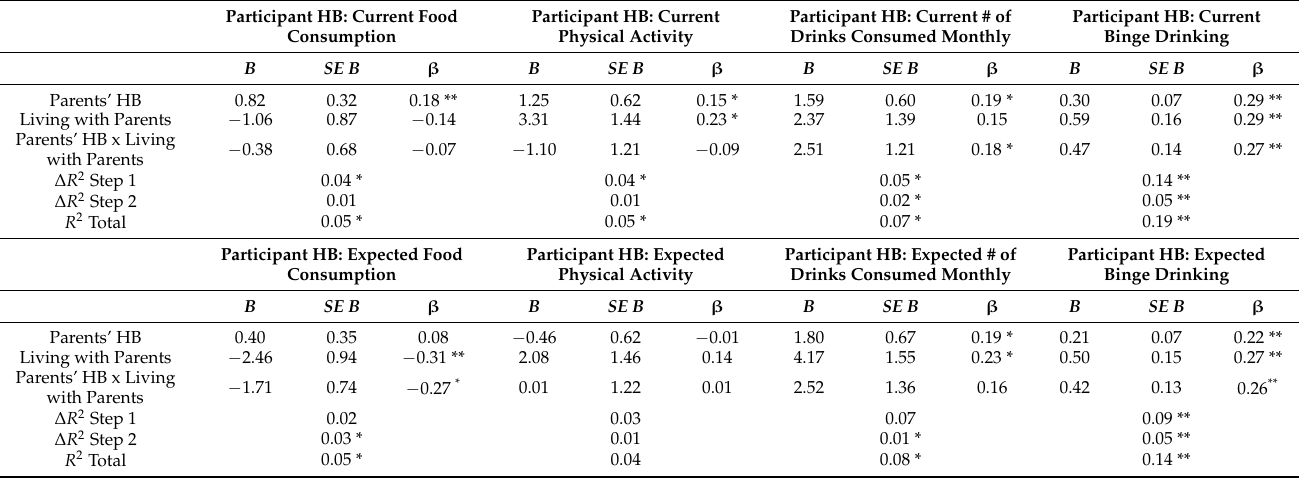
Table 1. Associations of living with parents and parental health behavior with students’ current and expected health behavior (Multiple regression